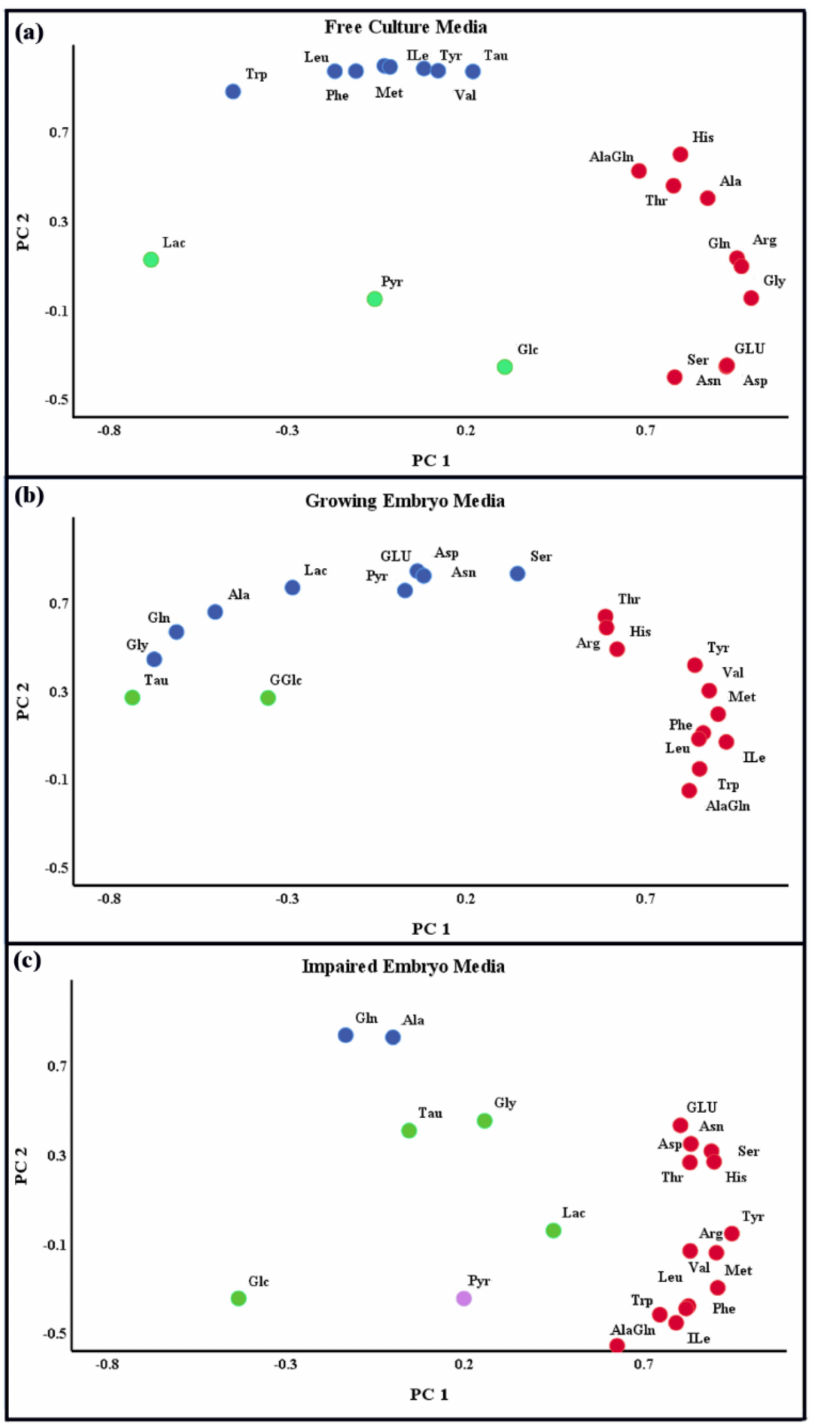
Figure 1. PC analysis of the free culture media ( a ), and the media containing the growing ( b ) and impaired embryos ( c ). Each circle represents di ff erent metabolites, wherein the color indicates their relativity. In the free culture media, the essential / conditionally-essential AAs, non-essential AAs, and carbohydrates are in separate groups with strong correlations. Nonetheless, this order is disturbed in the other two media, especially for the impaired embryos, when most of the AAs are correlated